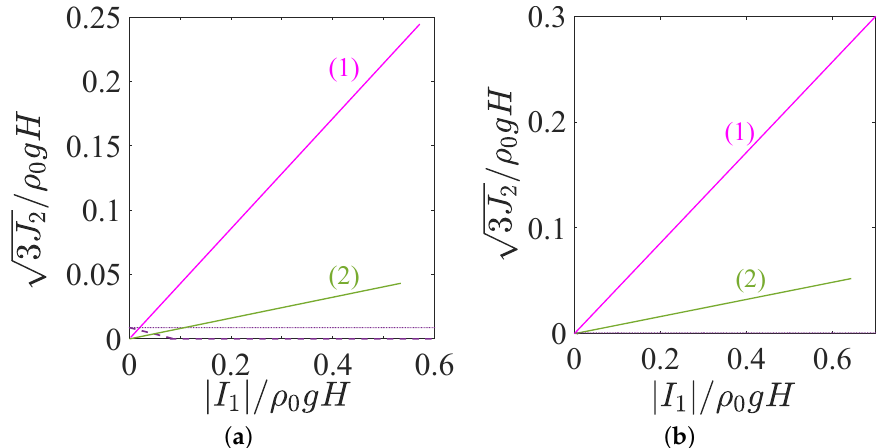
(cid:0) √ (cid:1) Figure 7. Values of the couple 3 J 2 / ρ 0 gH , | I 1 | / ρ 0 gH at different vertical positions. ( a ) Exper- iments of Kebiche et al. [13]: (1) κ = 1.14 × 10 − 3 , Λ = 0.306, Ψ = 0.238, (2) κ = 6.03 × 10 − 3 , − 3 . The dashed line is the Drucker–Prager criterion Λ = 1.325, Ψ = 1.257, σ y / ρ 0 gH = 8.83 × 10 for A = 0.1, and the horizontal line is the von Mises criterion ( A = 0). ( b ) Experiments of Dar- bouli et al. [12]: (1) κ = 8.58 × 10 − 4 , Λ = 9.94 × 10 − 2 , Ψ = 7.73 × 10 − 2 , and (2) κ = 4.53 × 10 − 3 , − 4 Λ = 0.431, Ψ = 0.409, σ y / ρ 0 gH = 8.83 × 10